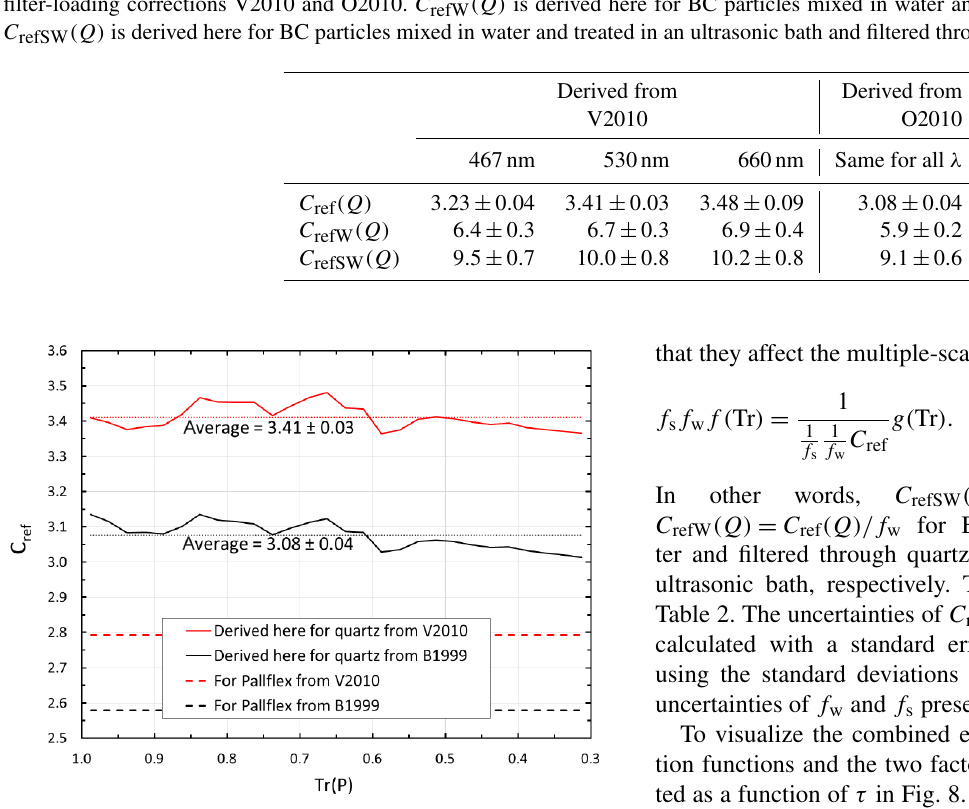
Figure 6. The multiple-scattering correction factor C ref for quartz and Pallflex filters in 0.025 bins of transmittance of Pallflex filter at λ = 530nm. The straight lines for C ref of O2010 and V2010 are those shown in Eqs. (9) and